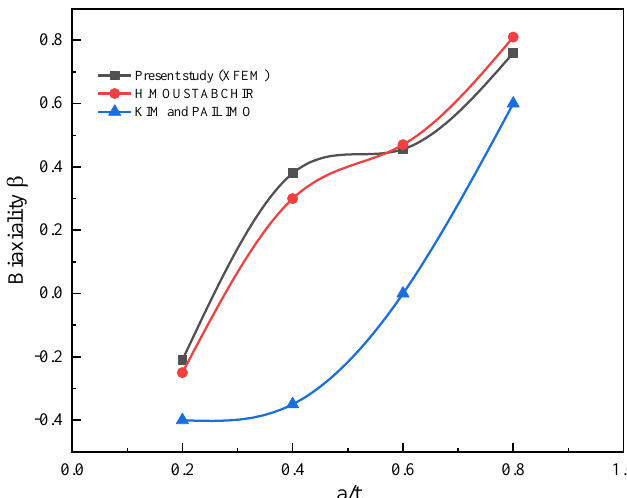
Figure 7. Variation of the biaxiality with a/t at the notch.